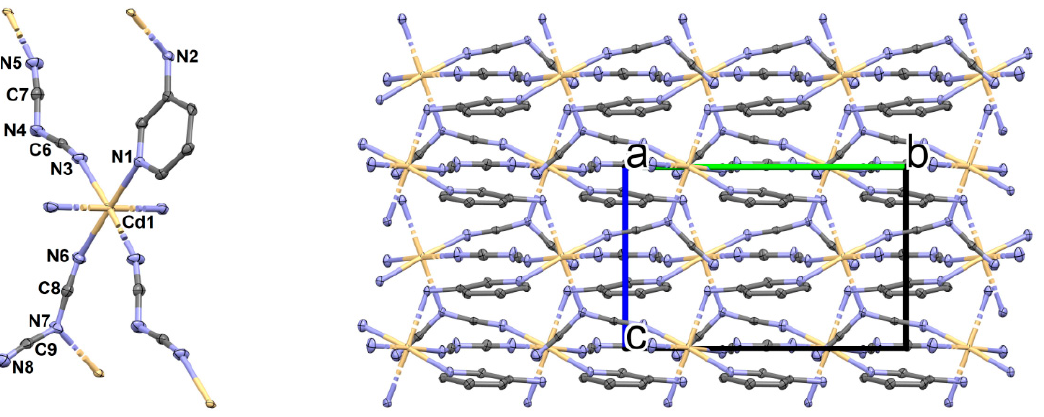
Figure 1. Coordination ( left ) and 3D network ( right ) of complex 1 . (Color code: yellow, Cd; blue, N; black, C.) Metal complexes containing both types of μ 1,3 - and μ 1,5 -bridging dca ligands have